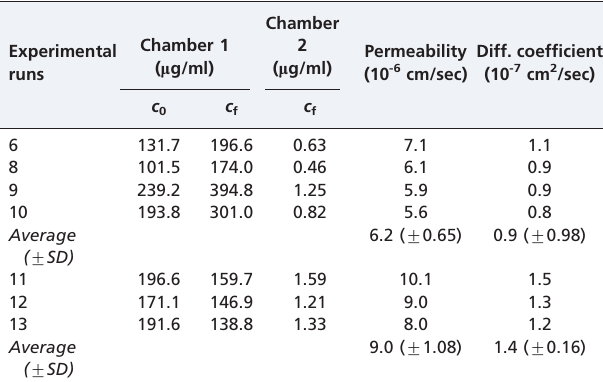
Figure 4 - Plot of ln(1 – 2 c t / c 0 )* for Dextran-FITC in water. The slope and R-squared values are shown. Table 1 - The measured and calculated values for the indicated parameters. Runs 6 through 10 used water as the solvent, and Runs 11 through 13 used PBS. Runs 6 and 8 used 100 m g/ml Dextran-FITC, and the rest of the runs used 200 m g/ml